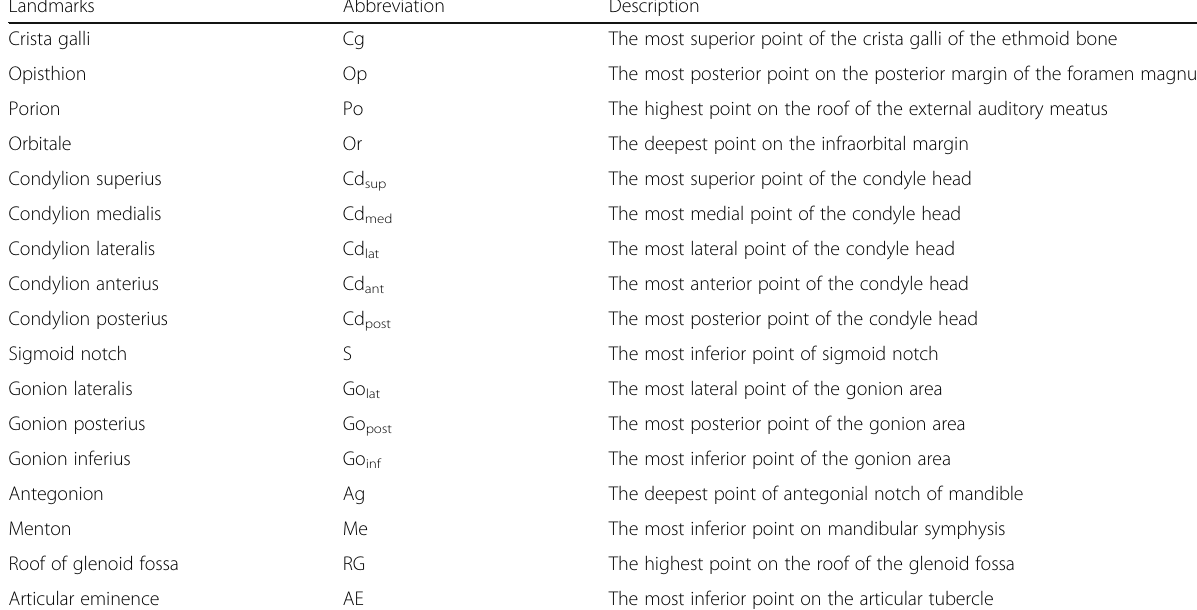
Table 1 The landmarks used in this study Landmarks